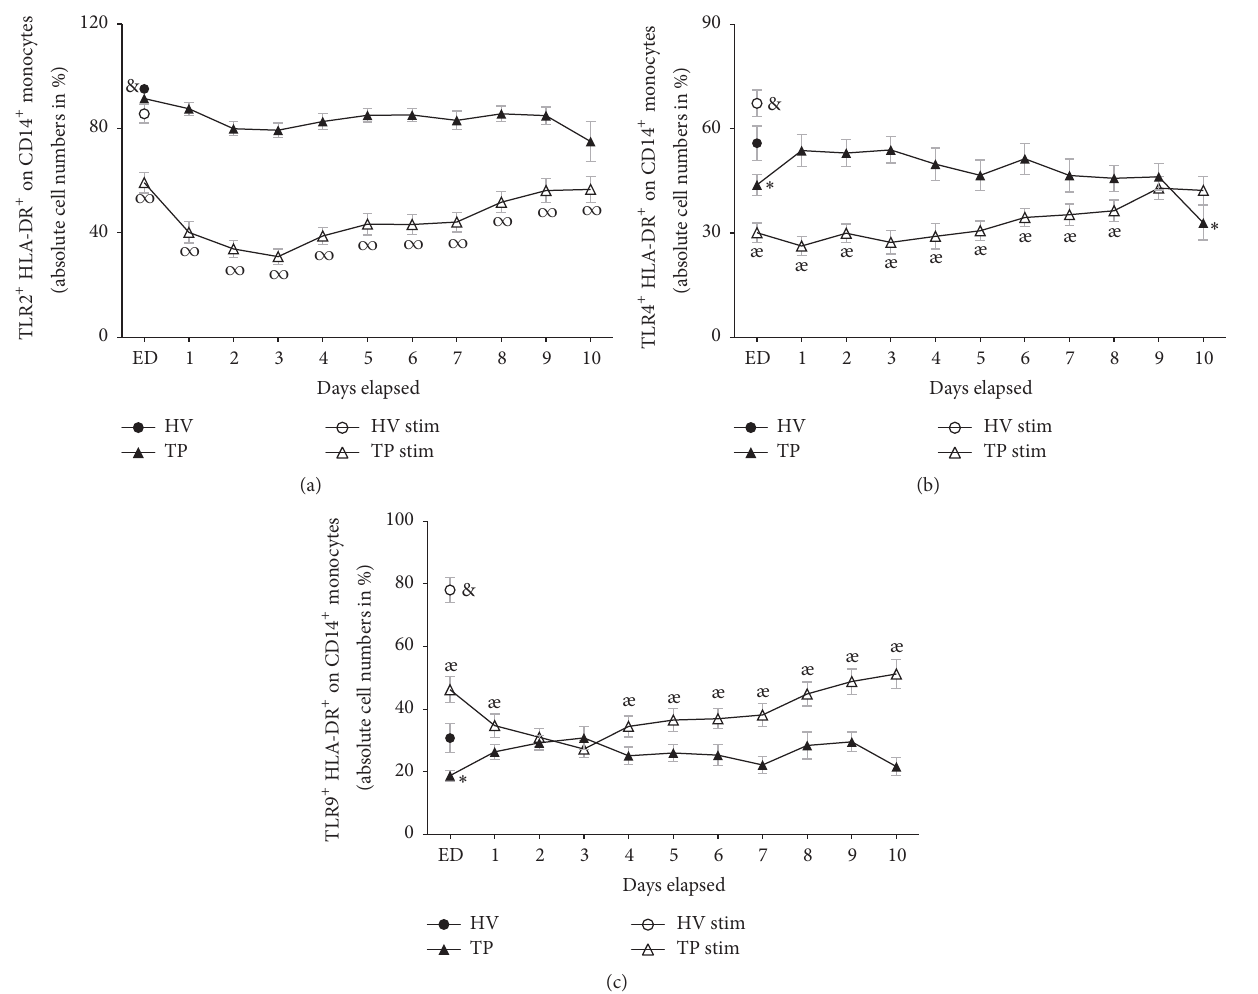
Figure 5: Whole blood from healthy volunteers (HV, 𝑛 = 14 ) or major trauma patients (TP, 𝑛 = 29 ) was analyzed by flow cytometry over a 10-day time course after admission (emergency department, ED–10). Monocytes were detected using anti-human CD14 in the corresponding sidewardandforwardscatter.Unstimulated(blacksymbols)andstimulated(clearsymbols)measurementsweremade.Forstimulation(stim), whole blood was incubated with leukocyte activation cocktail for 5h with subsequent analyzing procedure as in unstimulated samples. Data are shown as mean ± SEM. (a) TLR2/HLA-DR coexpression on CD14 + monocytes, (b) TLR4/HLA-DR coexpression on CD14 + monocytes, and (c) TLR9/HLA-DR coexpression on CD14 + monocytes. ∗ 𝑝 < 0.05 versus unstimulated HV; æ 𝑝 < 0.05 TP versus corresponding TP stim; & 𝑝 < 0.05 versus all; ∞ 𝑝 < 0.05 TP stim versus corresponding unstimulated TP and HV